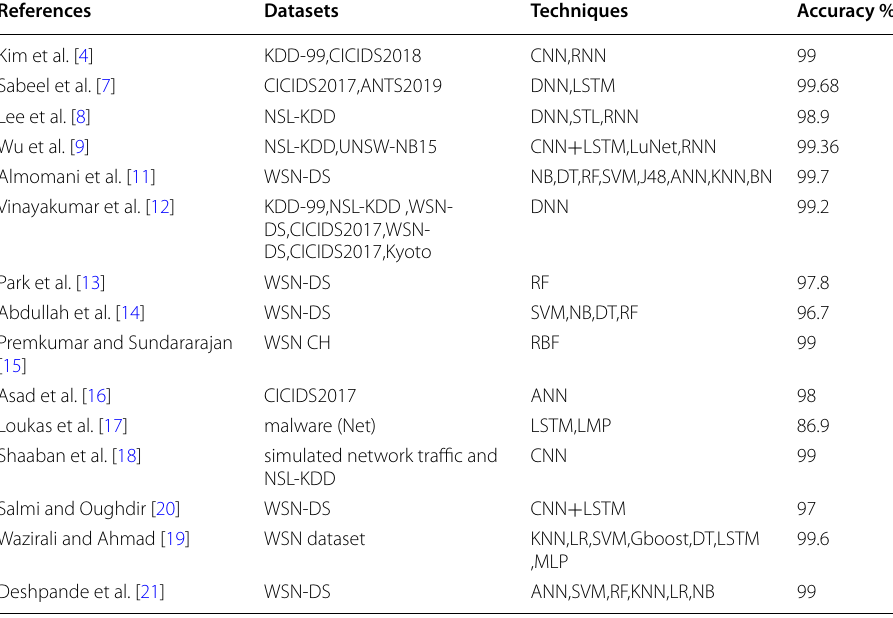
Table 1 the summarizes of reviewed detection methods,datasets used and accuracies